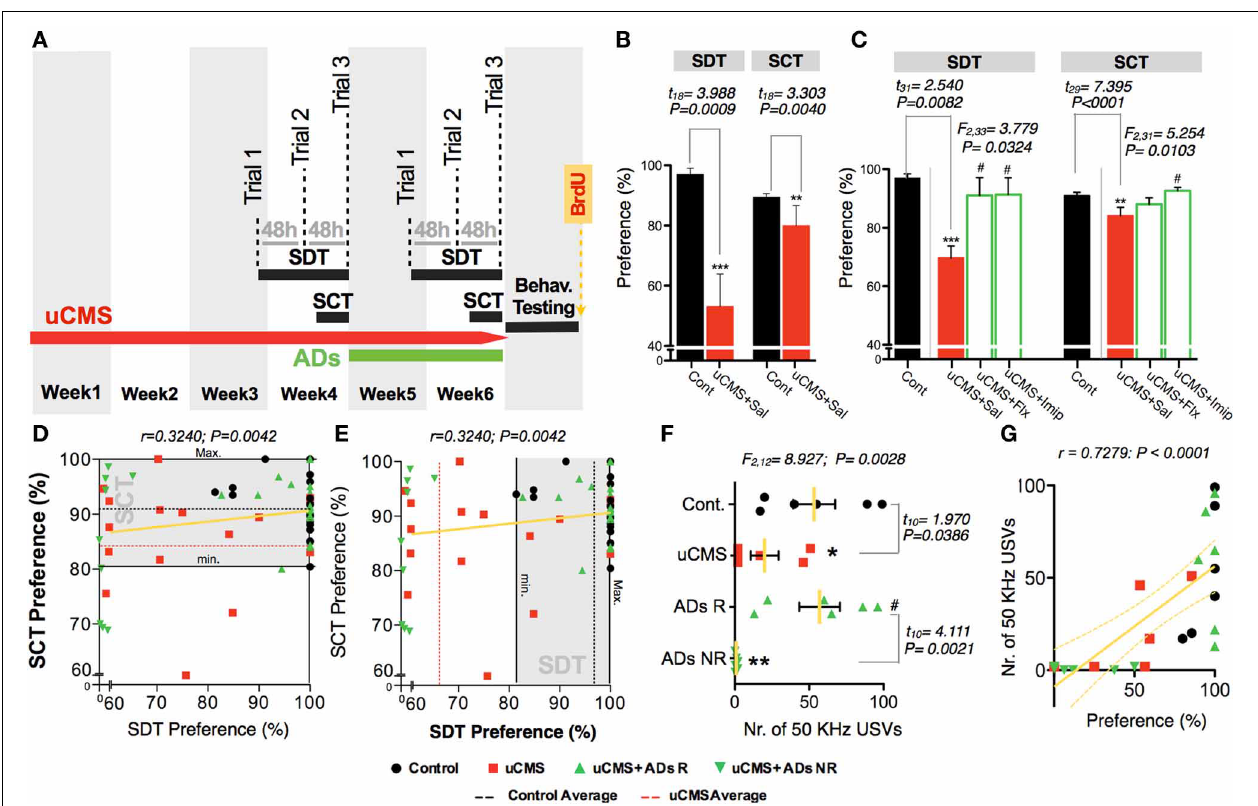
FIGURE 5 | Measuring the effects of uCMS and antidepressant treatment on anhedonic behavior with the Sweet Drive Test (SDT) and the Sucrose Consumption Test (SCT). (A–C) Anhedonic behavior was measured before (B) and after (C) 2 weeks of antidepressant treatment, in the SDT (data from the 3rd trial presented) and in the SCT ( n = 10–18). (D,E) Performances in both tests were correlated ( n = 68) and the ability of the tests to discriminate anhedonic behavior in untreated uCMS animals is showed as the density of red dots outside the performance range of control animals in each test